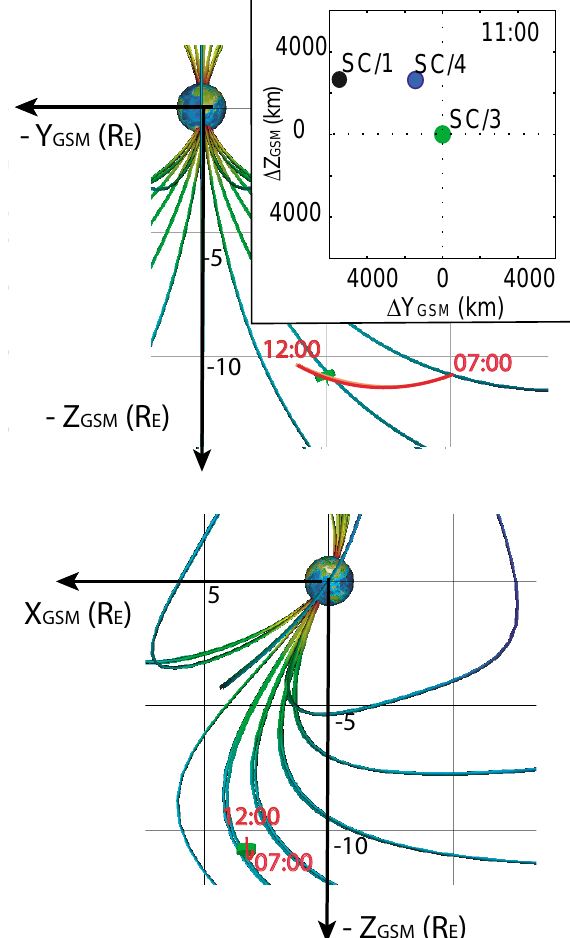
Fig. 1. SC/3 orbit on GSM XY and YZ planes from 07:00 UT to 12:00 UT on 3 December 2001. The spacecraft position corre- sponds to 11:00 UT. The insert shows SC/1 and SC/4 location re- spect to SC/3 on GSM YZ plane at 11:00 UT. The plot was created using the OVT program